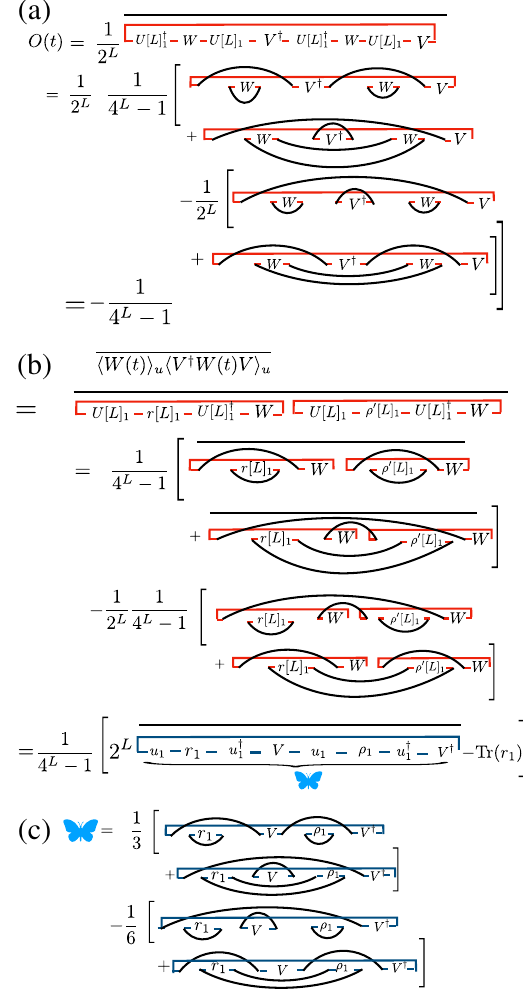
FIG. 9. Proof of Eq. (9) using a diagrammatic approach. In panels (a) and (b), the ensemble average is performed over the unitaries U leading to the contractions of the red indices. In panel (c), the ensemble average is taken with respect to the unitaries u 1 with the contracted indices shown in